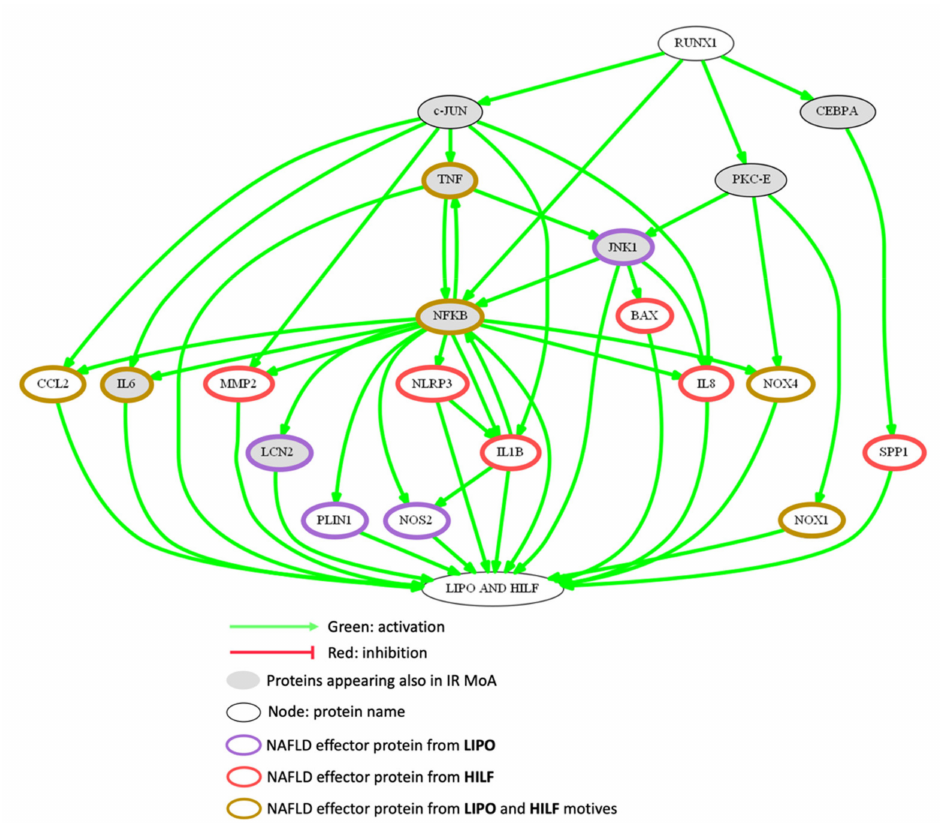
Figure 3. Most represented MoA of RUNX1 promoting lipotoxicity and hepatic injury and fibrosis in NAFLD in the population of TPMS model solutions. Gene names are used in the representations. RUNX1, runt-related protein 1; c-Jun, protein encoded by JUN gene; NF κ B, nuclear factor kappa B; PKC ε , protein kinase C epsilon; CEBPA, CCAAT/enhancer-binding protein alpha; SPP1, osteopontin; JNK1, c-Jun N-terminal kinase 1; BAX, BCL2 Associated X; CCL2, C-C motif chemokine 2; IL, interleukin; MMP2, matrix metalloproteinase-2; NLRP3, NACHT, LRR and PYD